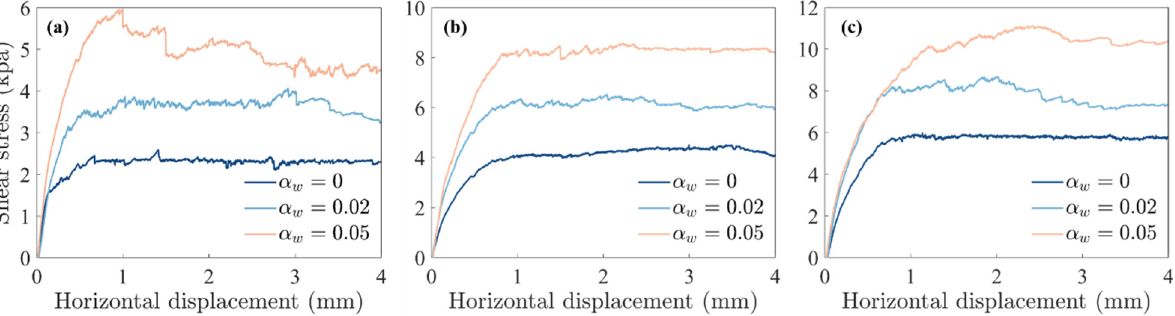
Figure 10. Comparison of the shear stress with loading horizontal displacement with different weakening coefficients α w at vertical stresses of ( a ) 30.00 kPa, ( b ) 44.08 kPa, and ( c ) 50.61 kPa.